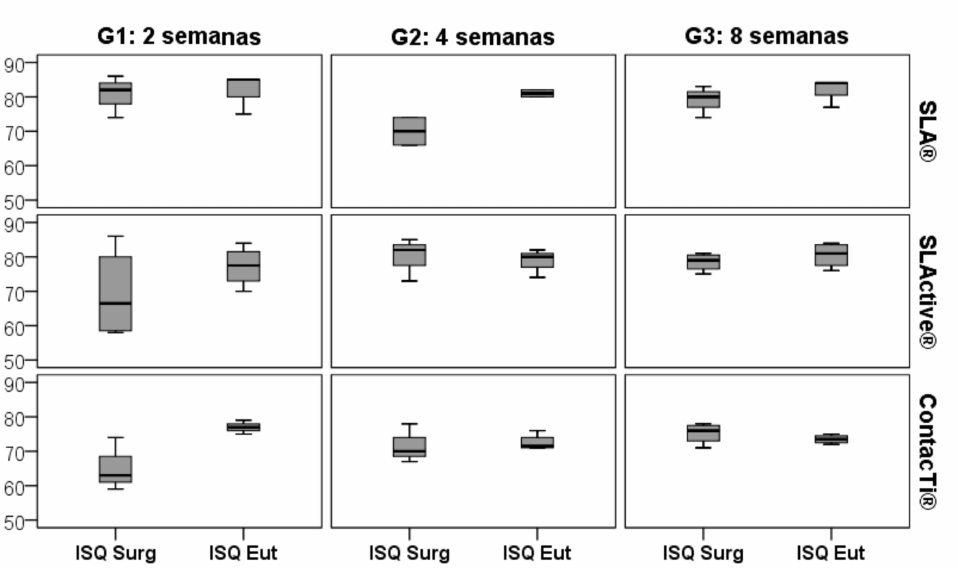
Figure 3. Boxplot for comparison of the ISQ SURG and ISQ EUT values by surface studied throughout the di ff erent time points of the